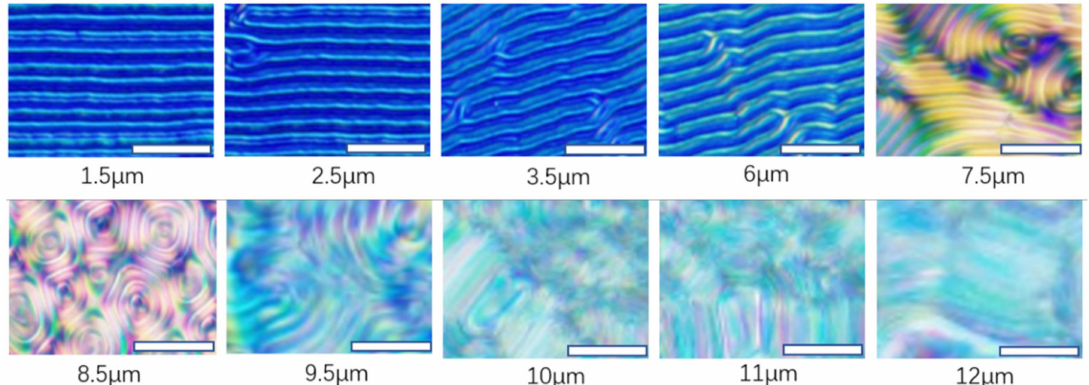
Figure 4. Morphologies transition of CLCs confined in cells of OTS-modified top surface and PMMAZO-modified bottom surface (0.025 wt% PMMAZO solution, 1.72 × 10 − 2 chains/nm 2 ) with different cell thicknesses. The scale bar is 10 µ